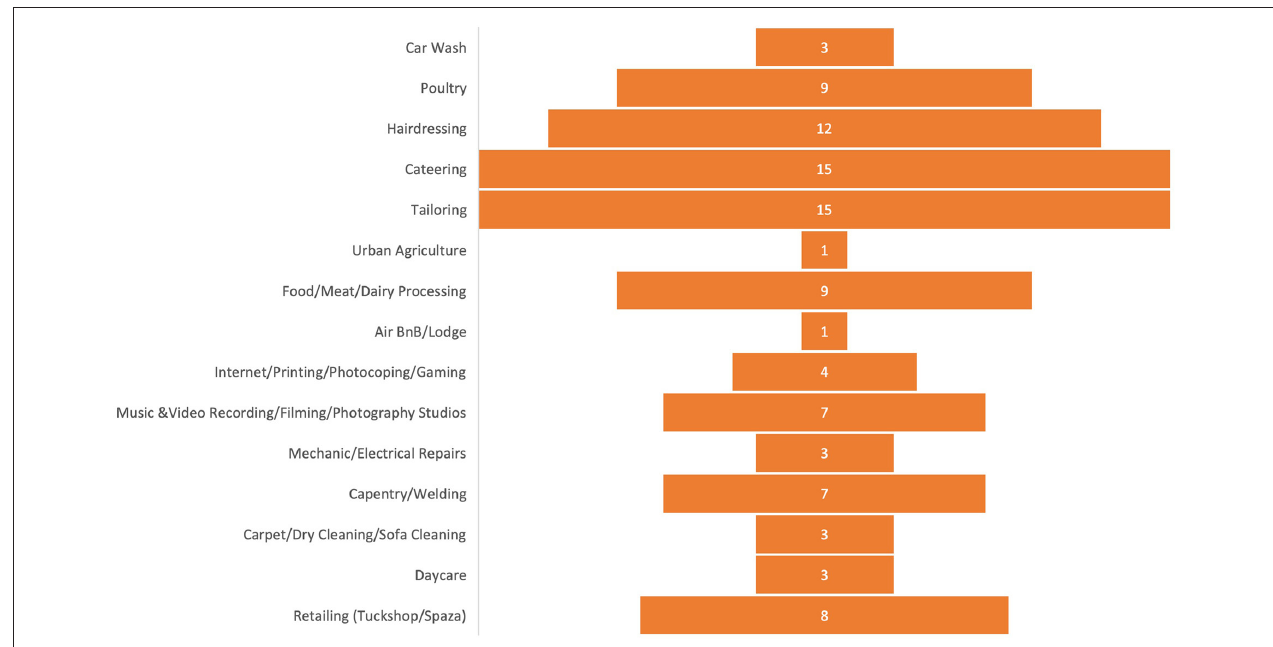
FIGURE 5 | Description of home-based electricity dependent informal businesses practised by women in percentages. Source: Field survey (2018).